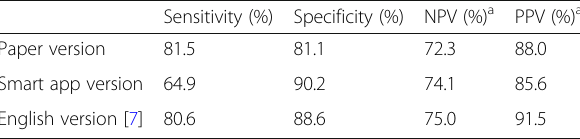
Table 4 Diagnostic accuracy of the ID-EC paper and smart app questionnaires